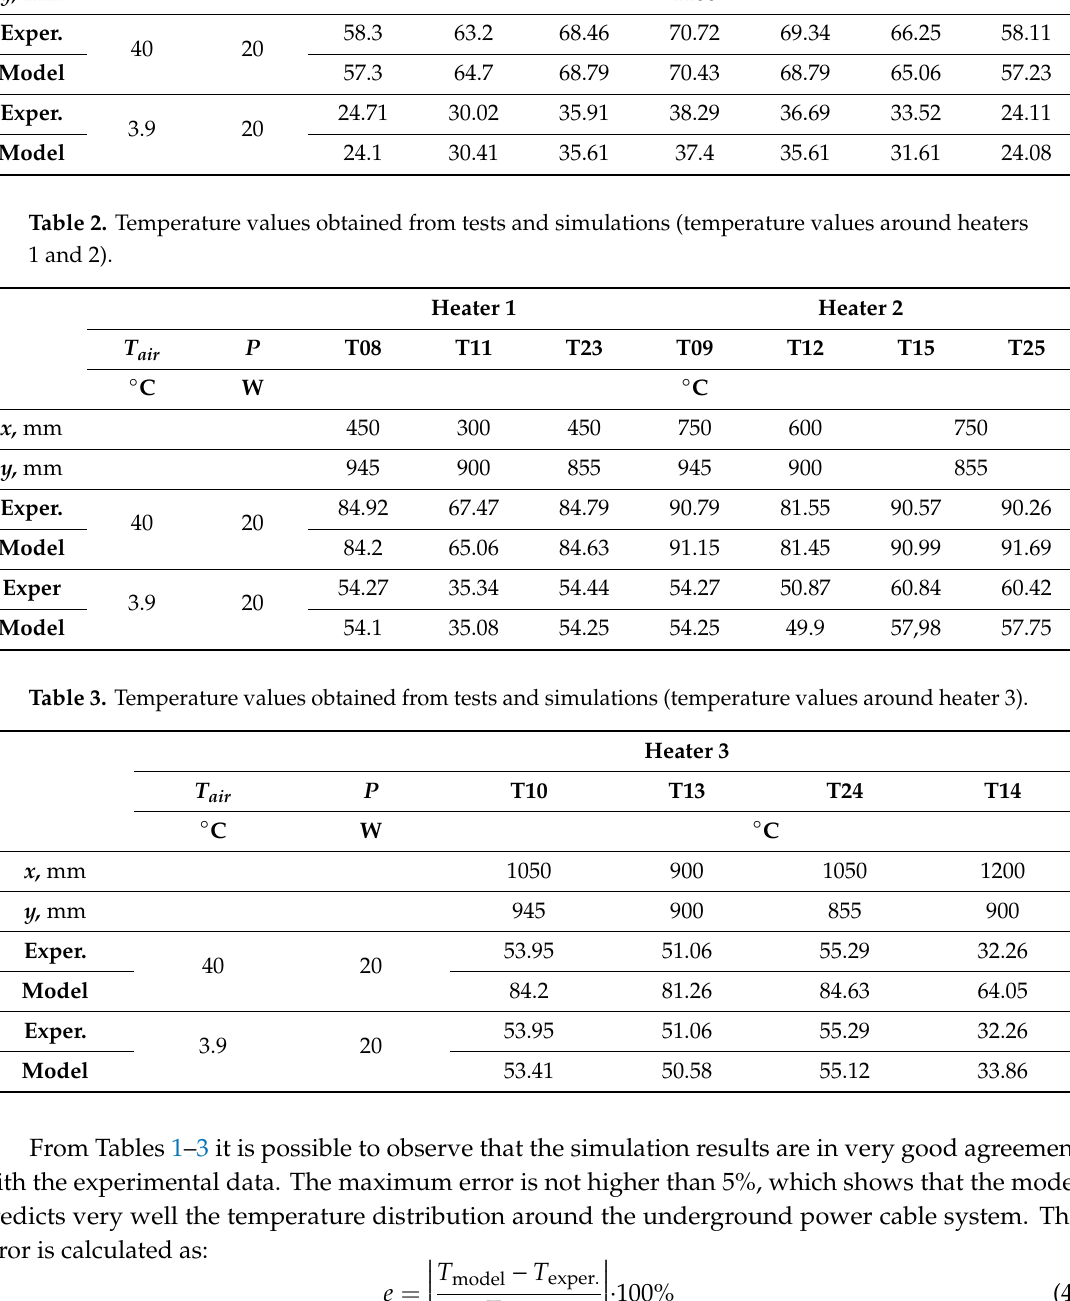
Table 1. Temperature values obtained from tests and simulations at a level of 200 mm above the heaters. T air W ◦ C x, mm 300 y, mm 1100 Exper. 40 Model Exper.